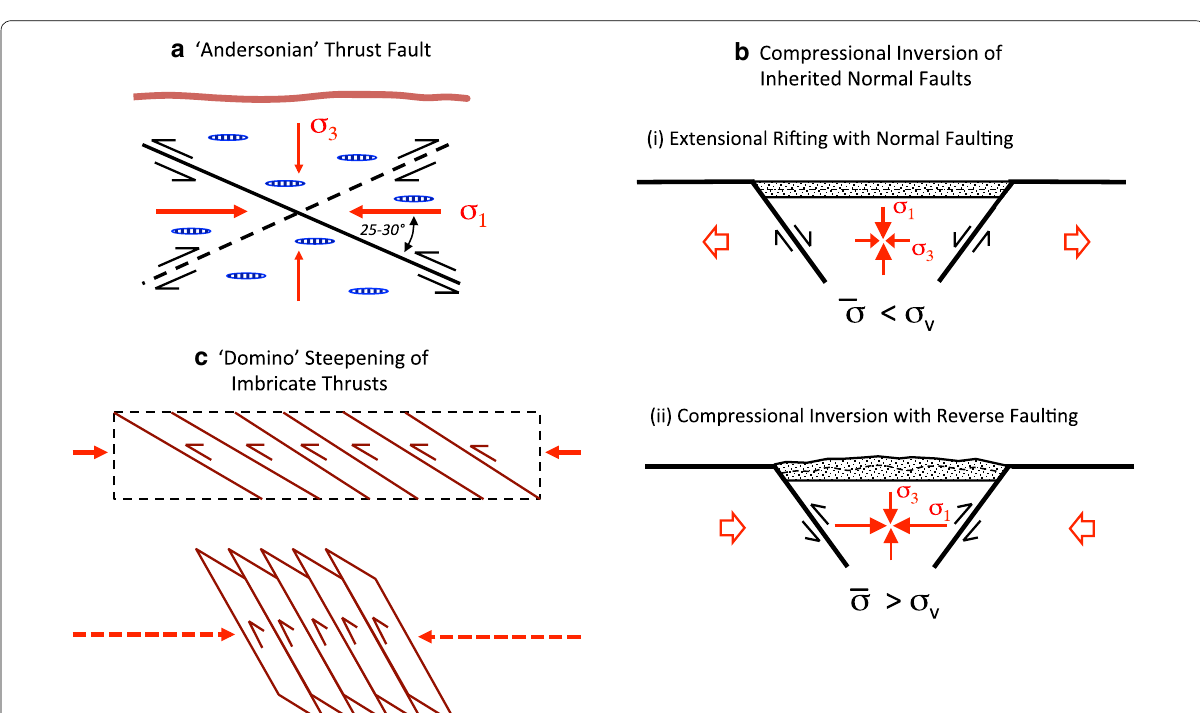
Fig. 7 a Initiation of an ‘Andersonian’ thrust fault dipping 25–30° within homogeneous, isotropic intact crust under horizontal compression; b steep reverse fault arising from compressional inversion of inherited normal faults; c steep reverse faults as a consequence of domino-steepening during progressive crustal